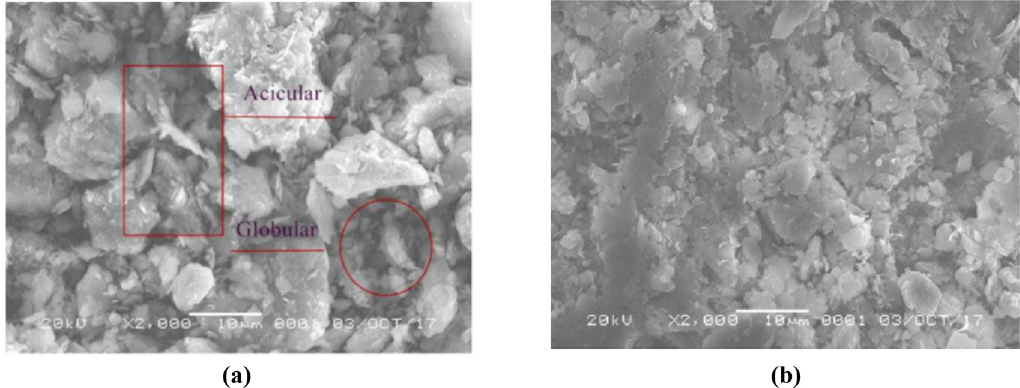
Figure 1: Microstructure improvement of the stabilised soil: ( a ) 0% nano - MgO and ( b ) 15% nano - MgO [ 2 ]